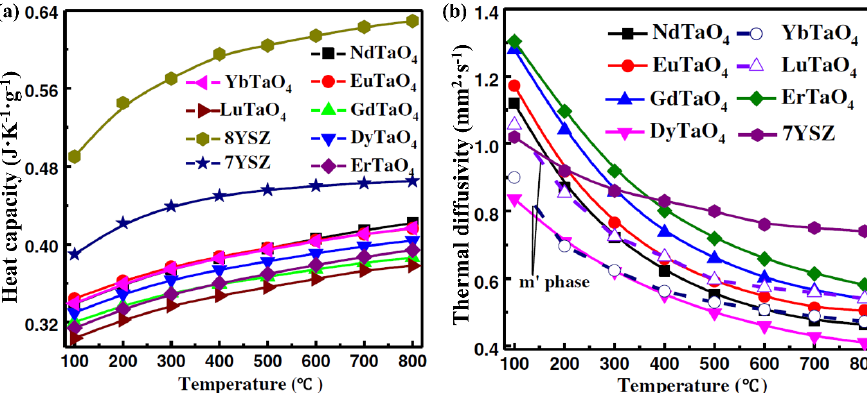
Fig. 14 Specific heat capacities and thermal diffusivities of RETaO 4 . (a) Dependence of the specific heat capacities of RETaO 4 (RE = Nd, Eu, Gd, Dy, Er, Yb, and Lu) ceramics on the temperature and (b) thermal diffusivities of RETaO 4 compounds and 7YSZ. Reproduced with permission from Ref. [84], © Acta Materialia 2016; Ref [87], © Chinese Journal of Aeronautics